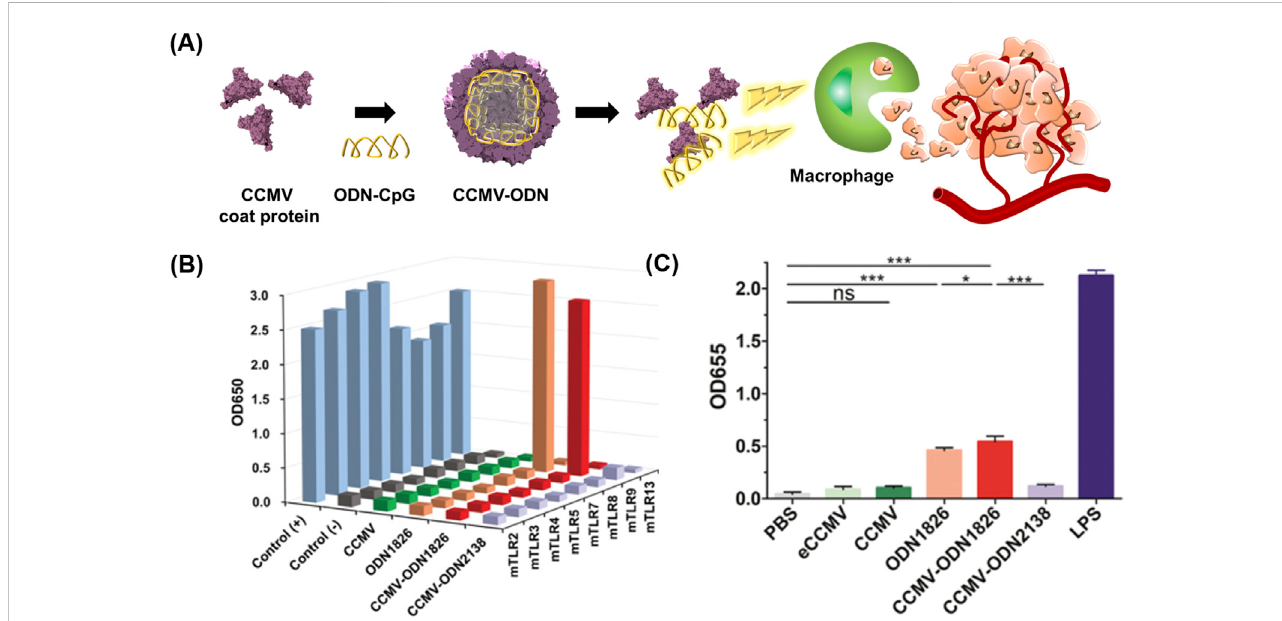
FIGURE 3 (A) Schematic diagram of preparing CCMV VLPs containing ODN 1826 (CCMV-ODN1826) for cancer therapy. (B) NF- κ B activation ability of CCMV- ODN1826. (C) Stimulation of pattern recognition receptors by CCMV-ODN1826 in RAW-Blue cells. Reprinted with permission from Cai et al.